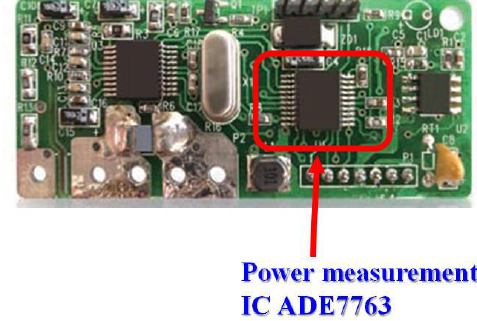
Figure 27. Power Measurement Module.